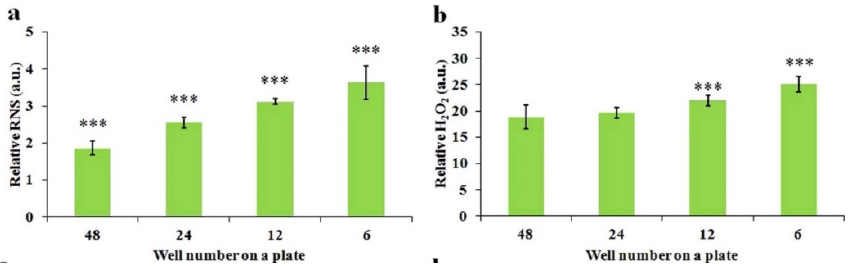
Figure 9. The well size-dependent ROS/RNS accumulation in PTS. ( a ) Relative RNS concentration in 1 mL of PTS. ( b ) Relative H 2 O 2 concentration in 1 mL of PTS. Student’s t -tests were performed and the significance compared with the first bar is indicated as *** p < 0.005. Reproduced from [75]. Copyright 2015 Springer Nature.